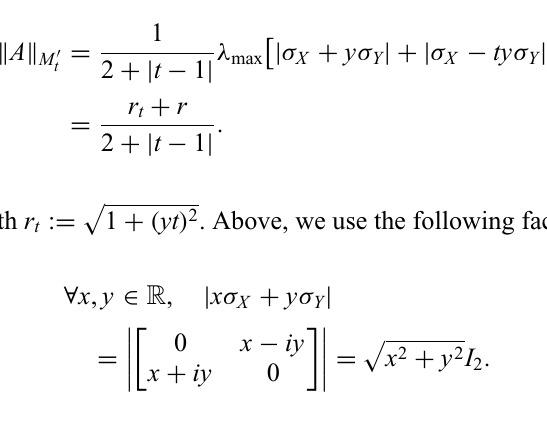
) = 1 in Fig. 5, and the ratio of the two norms in M t Fig. 6. Note that the plot for t = 1 corresponds to the CHSH game: the two norms are equal [see Eq. (7)]. At FIG. 4. The norm (cid:2) A (cid:2) for M (cid:17) t y ∈ [ − 1, 1] and different values of t . The measurements A are σ X and y σ Y , a noisy version of σ Y